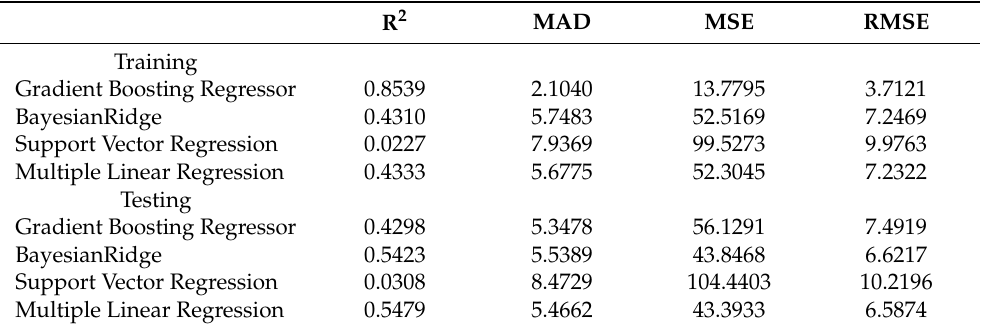
Table 6. Results comparison of GBR with the other three methods on saliva